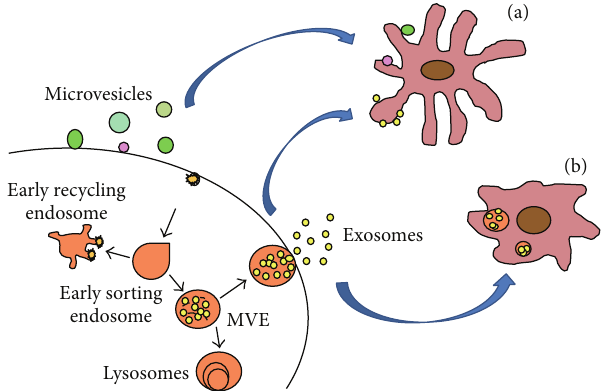
Figure 1: Exosomes are released from host cell and uptook by recipient cells. Exosomes are generated in host cell by merging MVBs with the cell membrane and releasing into the extracellular space. These exosomes can be fused with the plasma membrane (a) or be internalized (b) by recipient